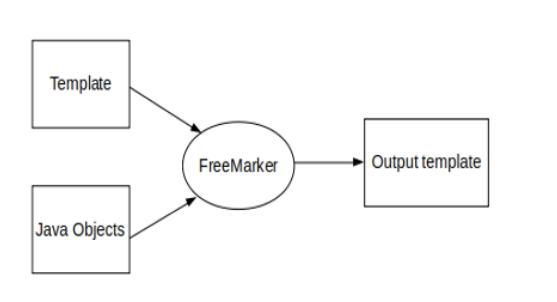
Figure 2. Architecture diagram of Apache